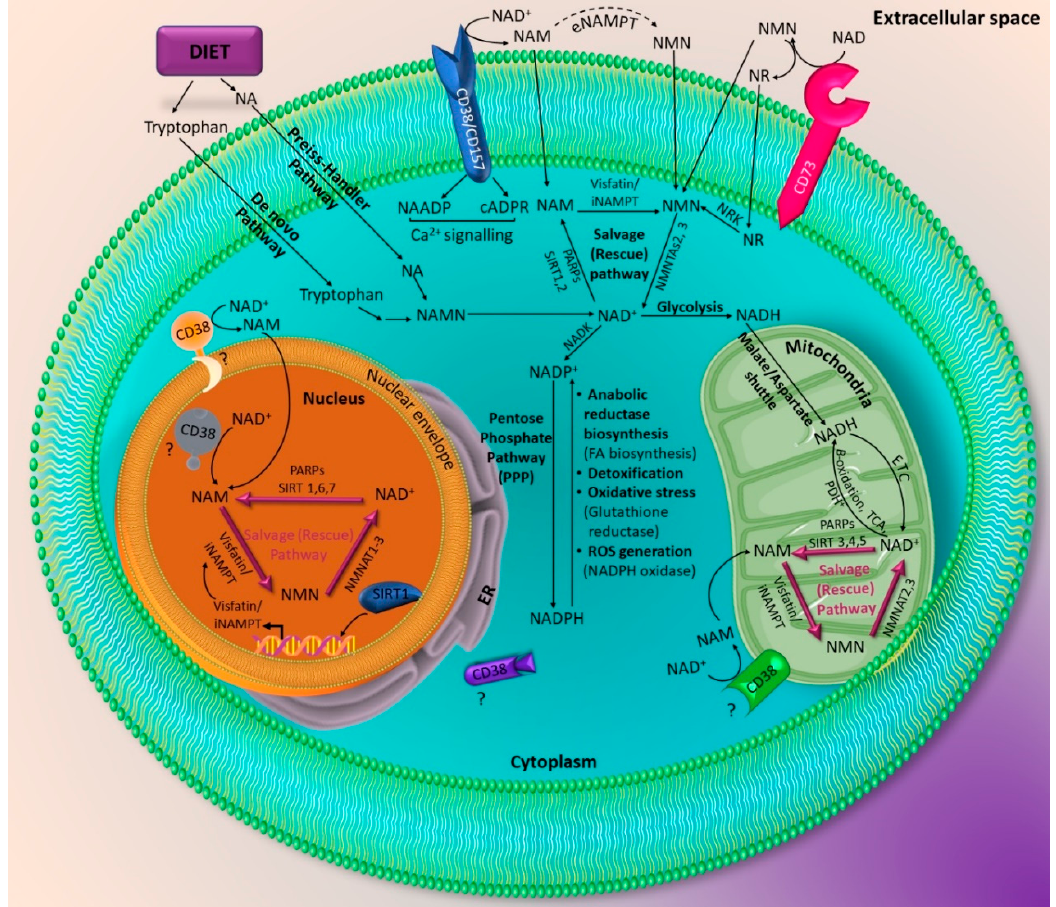
Figure 3. Various physiological roles of intracellular visfatin (iNAMPT). iNAMPT can be located in the cytoplasm, nucleus, and mitochondria. iNAMPT triggers its effects by regulating the levels of the core molecule NAD + . NAD + levels are maintained through the de novo, Preiss–Handler, and salvage pathways. NAD + is heavily converted to NAM by several cellular NAD + dependent enzymes which include SIRT 1, 2 in the cytoplasm, SIRT 1, 6, 7 in the nucleus, and SIRT 3, 4, 5, in the mitochondria and PARPs. NAM will be converted to NMN via iNAMPT which is the rate limiting step in the salvage pathway. NAD + can be regenerated from NMN via nicotinamide mononucleotide adenylyltransferases (NMNATs). The ectoenzyme CD38 converts NAD + to NAM to produce NAADP and cADPR involved in intracellular Ca 2+ signaling. CD38 can be also present on inner/outer mitochondrial membrane or inner/outer nuclear envelope. NAD + can be metabolized extracellularly to NMN via the ectoenzyme CD73. NAD + is a core molecule that plays a role in basic cellular metabolism. NAD + is a key substrate for glycolysis, the tricarboxylic acid cycle (TCA), pyruvate dehydrogenase (PDH), beta-oxidation yielding NADH. The reduced form NADH can be regenerated via electron transport chain (ETC). NAD + exist also in a phosphorylated form NADP+. The reduced form NADPH determines the anti-oxidative power of the cell. It is involved in anabolic biosynthesis (fatty acid (FA) biosynthesis), detoxification, cellular responses during oxidative stress via glutathione reductase, and protection against reactive oxygen species (ROS) via NADPH oxidase. NR: nicotinamide riboside. + NAMPT and CD38 exert opposite effects on NAD availability. In fact, NAMPT inhibition has been found to have similar metabolic consequences of CD38 expression [69]. For example, age-related decreases + in NAD levels is associated with increased CD38 levels [70,71]. Thus, CD38 inhibitors and NAMPT + activators constitute a promising area to maintain high levels of NAD with